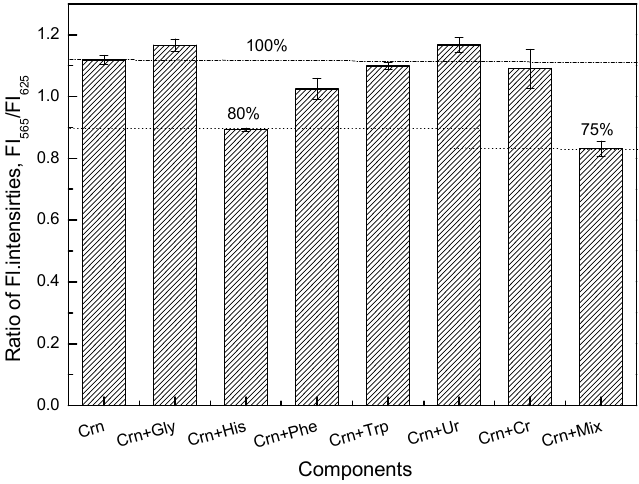
Figure 10. Response of the creatine-sensing membrane to aqueous solutions of 1.0 mM creatinine (Crn) and 0.2 mM of each of the following components: Gly: glycine, His: histidine, Phe: phenylalanine, Trp: tryptophan, Ur: urea, Cr: creatine, and Mix: mixture of Gly, His, Phe, Trp, Ur, and Cr. Table 2. Summary of the analytical performance of some optical methods for creatinine detection. Detection Method (Enzyme or Assay Used)